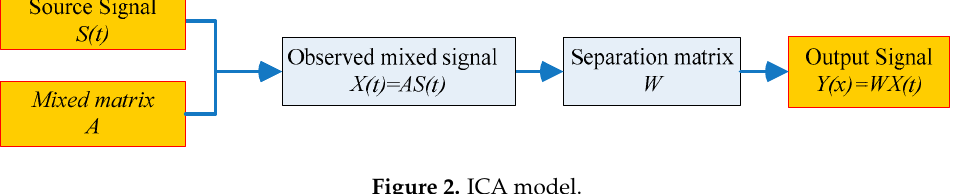
Figure 2. ICA model.